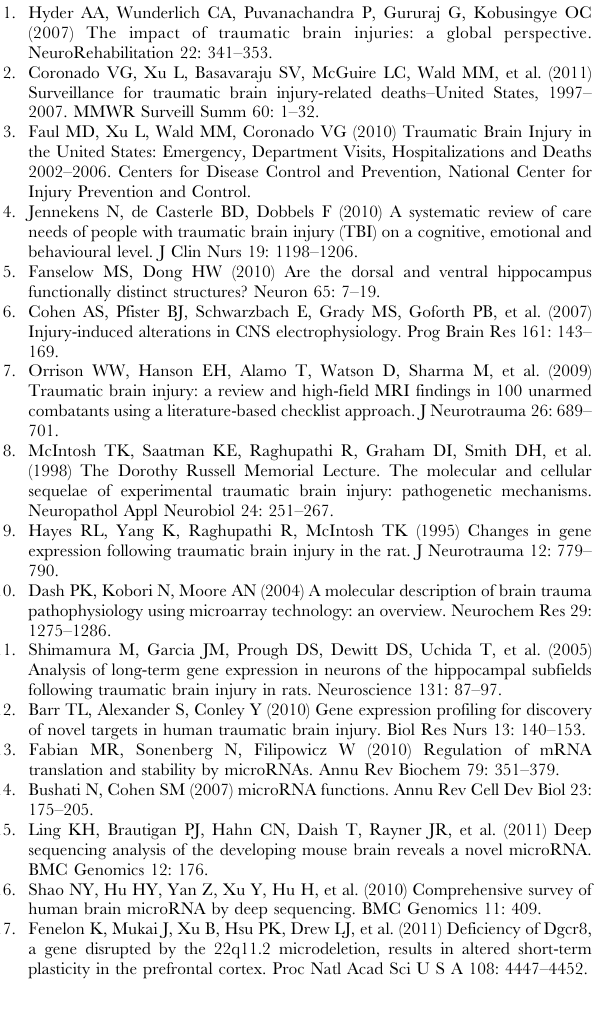
Table S2 Summary of miRNA-gene-GO enrichment analysis. The number of miRNAs in each test group and the number of genes over-expressed by each miRNA test group are listed. Table S3 Clustering of GO terms. GO terms enriched by each miRNA test group are classified into functional groups according to the biological functions they are associated